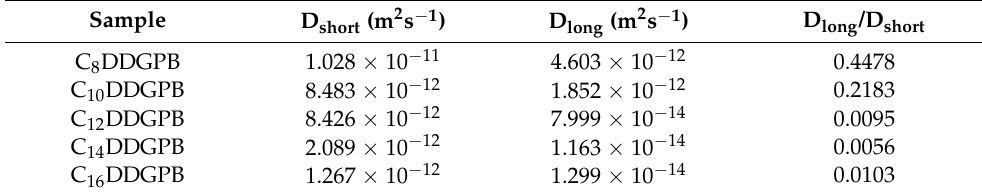
Table 2. Apparent diffusion coefficient of C n DDGPB (5.0 mmol/L). Sample